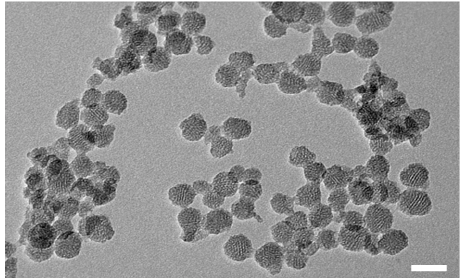
Figure 2. TEM image of the MSNs with the pore structure. Scale bar = 50 nm.